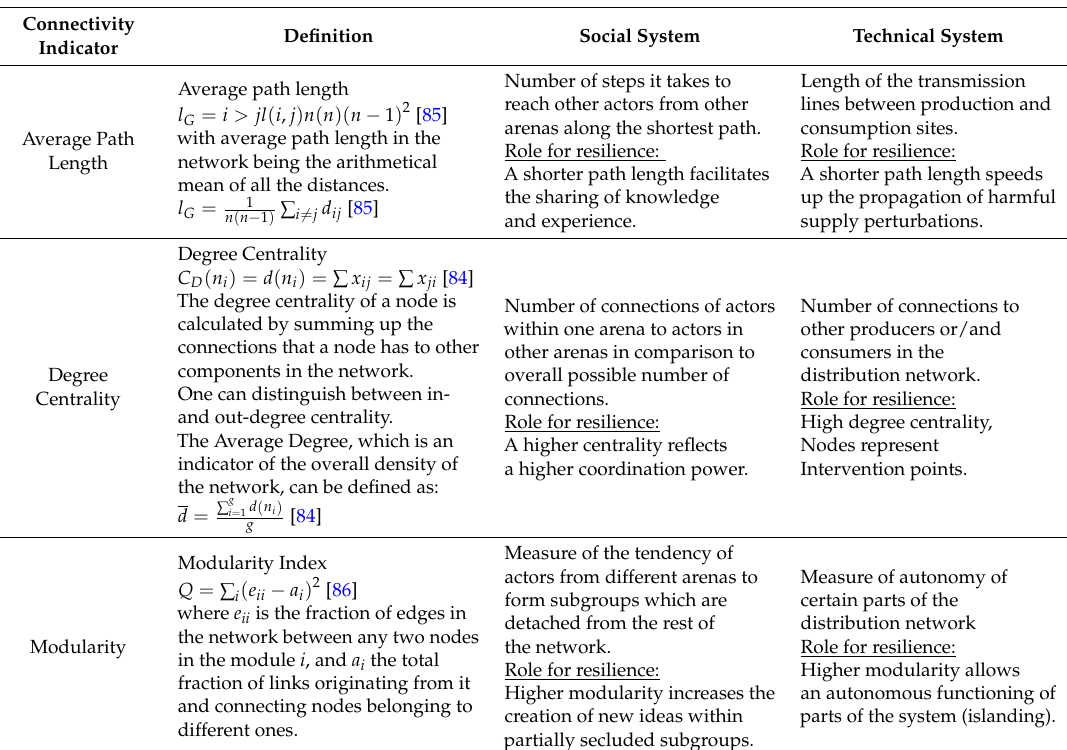
Table 2. Suggested measures for operationalizing connectivity in socio-technical energy